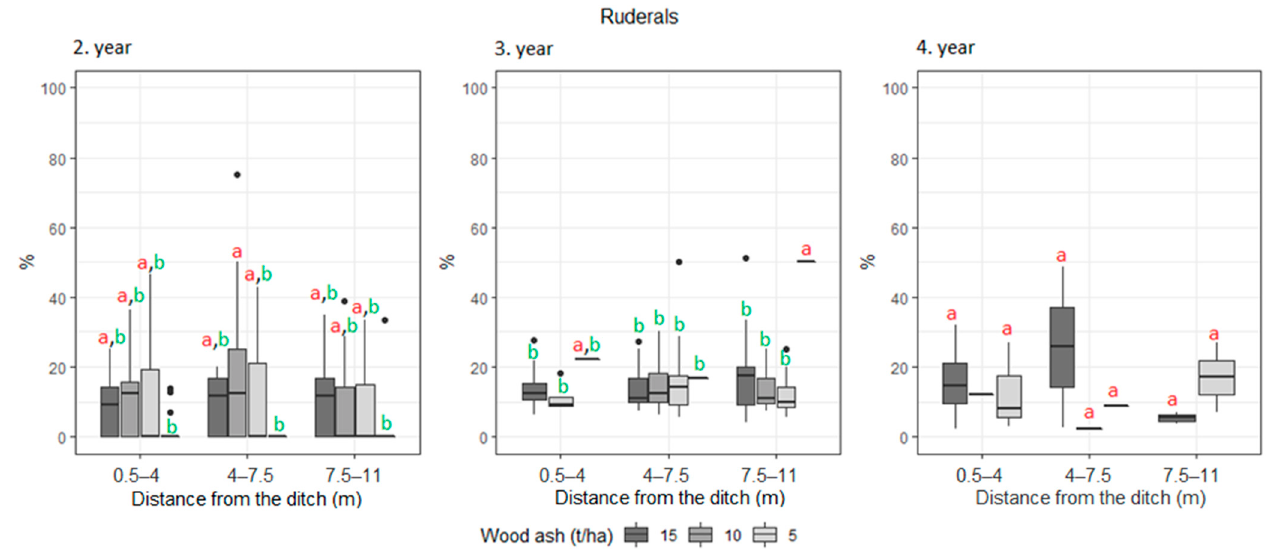
Figure A8. Relative of plants with competitor universal adaptive strategy from the total vegetation cover, depending on the distance from the drainage ditch and the dose of wood-ash fertiliser. Dif- ferent letters (a, b, c) indicate significant differences between groups, p < 0.05 according to the Tukey HSD test.